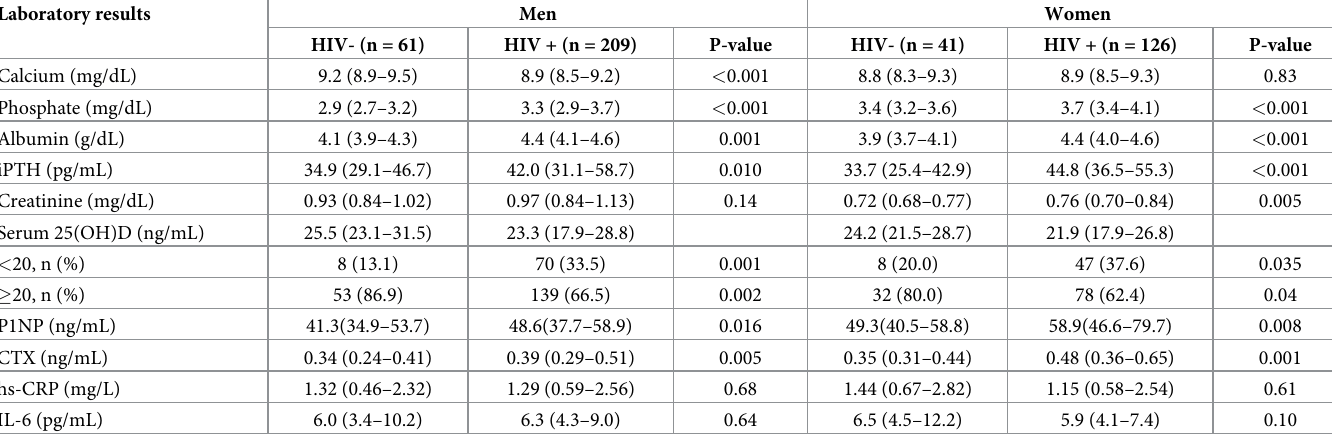
Table 5. Calciotropic hormones, and markers of bone turnover and inflammation. Laboratory results